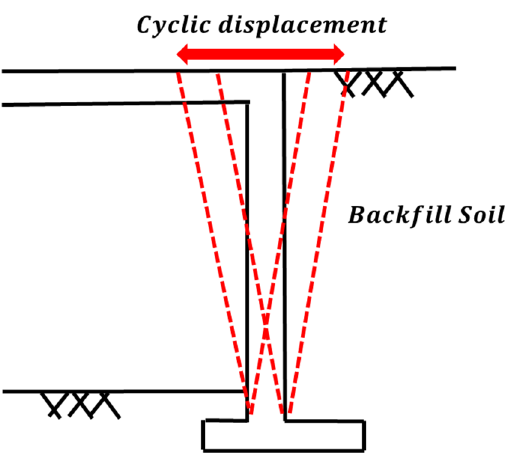
Figure 1. Cyclic displacement of abutment due to changes in deck length.